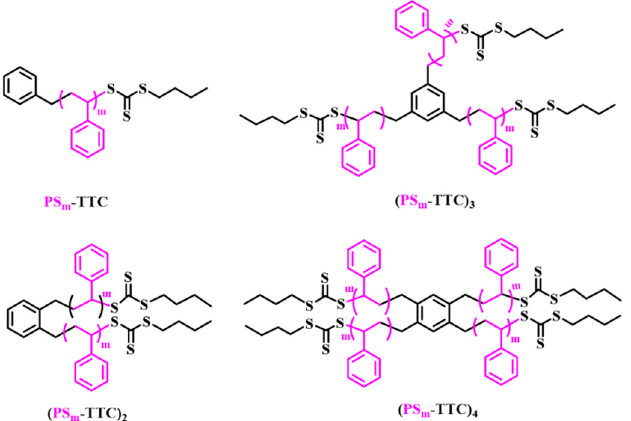
Scheme 1. (PS m -TTC) n